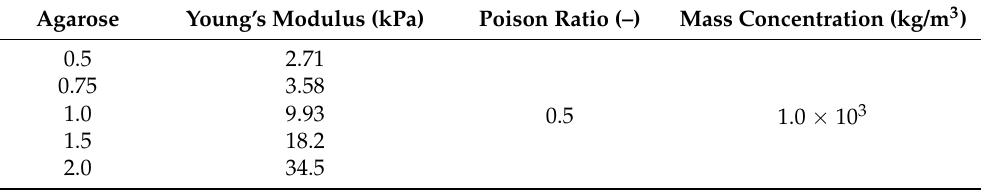
Figure 4. Numerical analysis models for ( a ) the petri-dish-based and ( b ) the cuvette-based spheroid culture models with external compressive stress. Table 1. Material parameters of the agarose gels with different mass